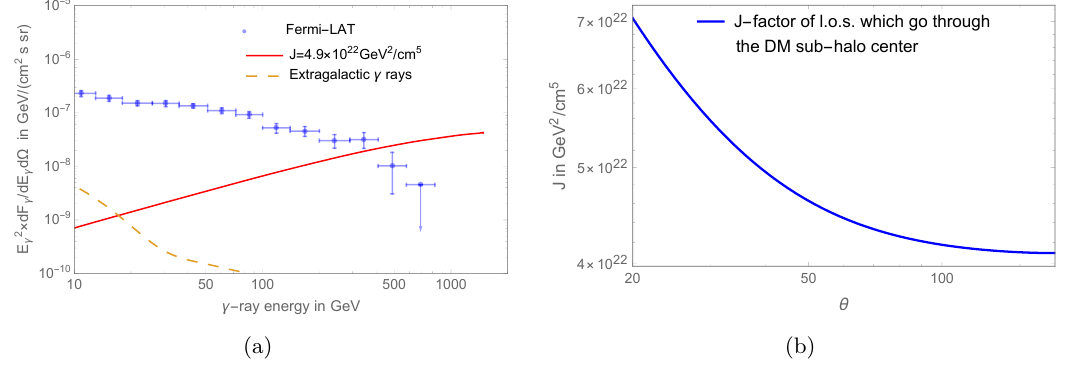
Figure 5 . (a) IGRB (multiplied by E 2 ). The blue points with error bars are the flux measured by Fermi-LAT. The solid line shows the prompt emission when the J-factor is 4 . 9 × 10 22 GeV 2 / cm 5 . The dashed line shows the photon flux contributed by extragalactic DM. (b) In the figure, we